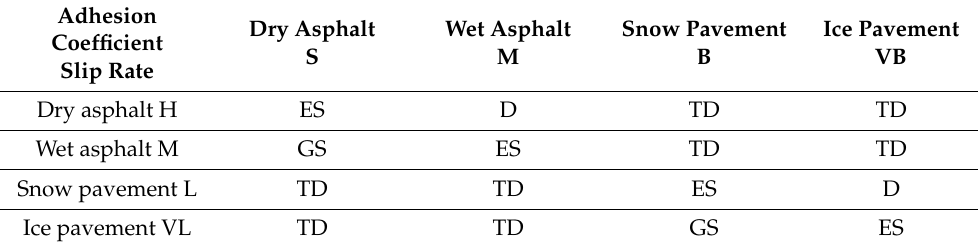
Table 2. Fuzzy control rules for road surface